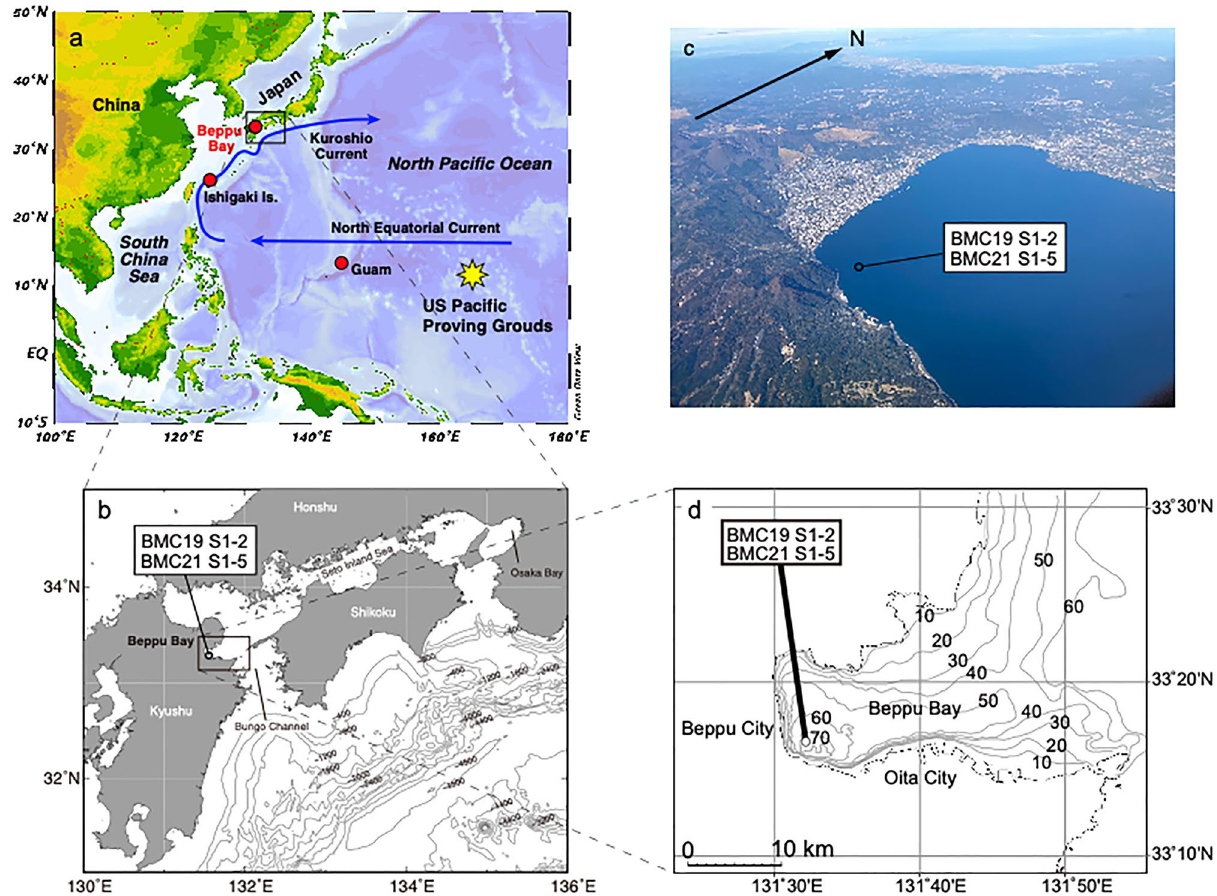
Figure 1. Location of Beppu Bay and key locations in the North Pacific Ocean. ( a ) The US pacific proving ground (PPG) is located east of Guam, and the North Equatorial Current (NEC) and Kuroshio Current (KC). The software Ocean Data View Ocean Data View 5.4.0 (Schlitzer, R., Ocean Data View, http:// www. awi- breme rhaven. de/ GEO/ ODV,2003.) was used to draw the map. ( b ) Beppu bay is located at the entrance of Setonaikai Inland Sea and is connected to the Pacific Ocean via the Bungo Channel. Map was generated using GMT with topographic data of ETOPO1 (https:// www. ngdc. noaa. gov/ mgg/ global/ global. html). ( c ) Aerial photo of Beppu Bay. The coring site for this study is also indicated. ( d ) Contours indicating the water depth in meters showing anoxic bottom water conditions are created by the depicted bathymetric feature. The map was drawn using the chart distributed by the Hydrographic and Oceanographic Department, Japan Coast Guard (https:// www1. kaiho. mlit. go. jp/ jhd-E.